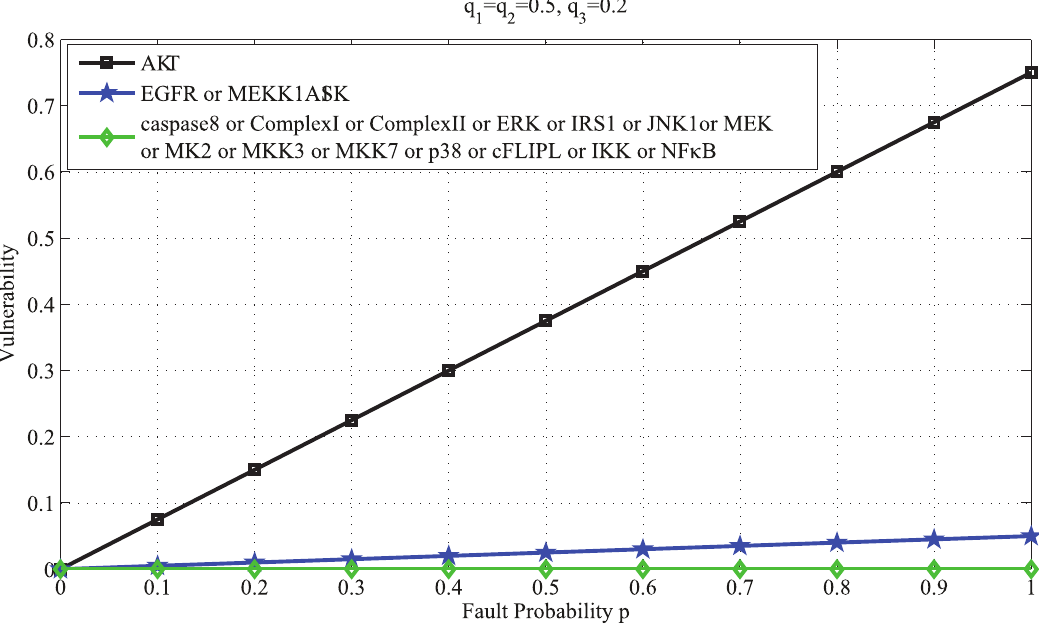
Figure 8. Vulnerability versus the fault probability p for all the molecules in the caspase3 network, while TNF activity is low. Here TNF activity is 0.2, whereas EGF and insulin activities are fixed at 0.5. We observe that the vulnerability of AKT rapidly increases with p , whereas the vulnerability of other molecules are almost zero. This indicates the critical role of AKT in the network.